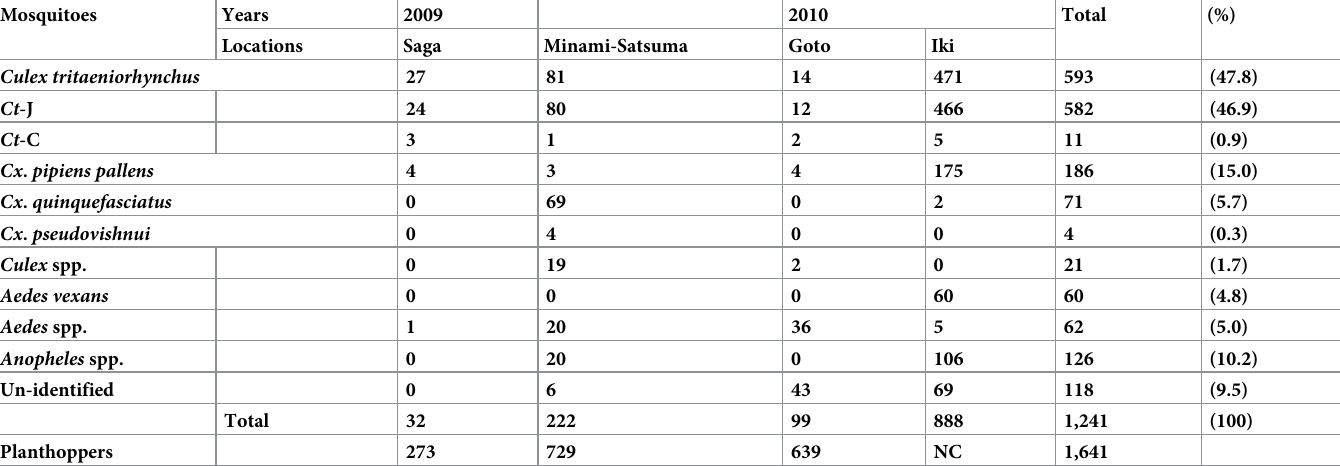
Table 2. Mosquitoes captured in net traps and a Johnson-Taylor suction trap in 2009 and 2010.